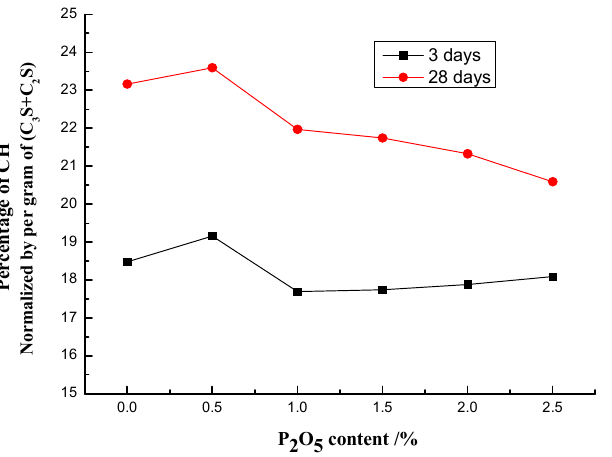
Figure 8. The effect of P 2 O 5 content in cement clinkers on the formation rate of Ca(OH) 2 in ce- ment